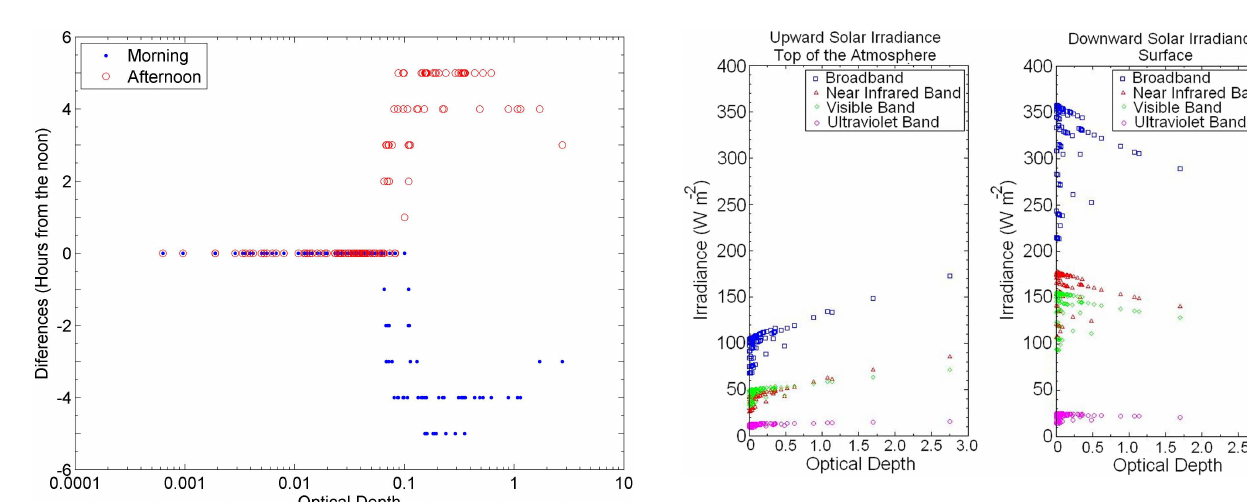
Fig. 3. Daily mean solar irradiance in presence of cirrus clouds. Upward irradiance at TOA and downward irradiance at SFC, for the solar radiation broadband and spectral bands, versus cirrus optical depth for the all cirrus measured with lidar in